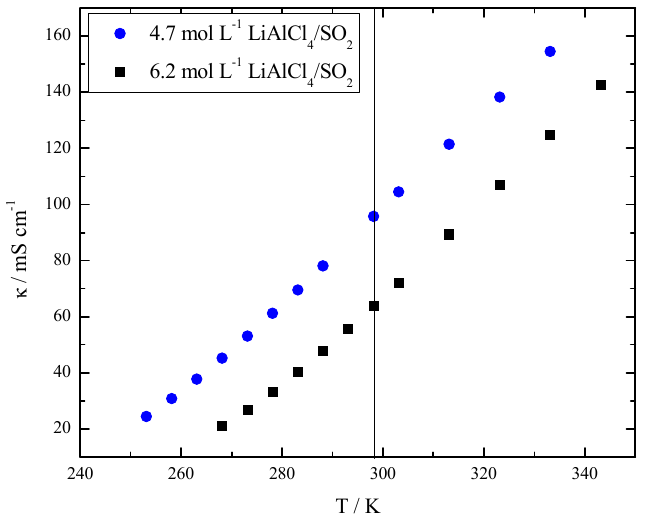
Figure 3. Temperature dependent specific conductivity of 4.7 mol L − 1 and 6.2 mol L − 1 in SO . LiAlCl 4 2